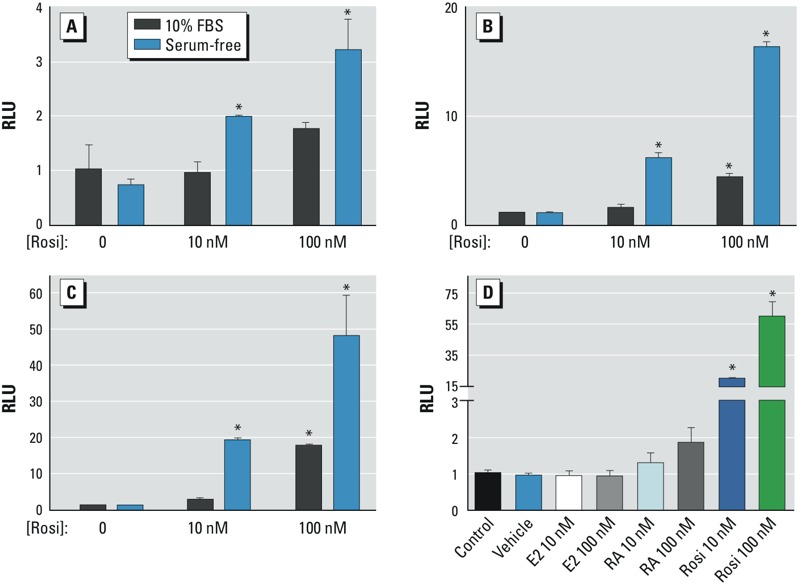
PPARγ transactivation activity in a GAL4-UAS system using serum-free conditions. HEK293T/17 cells were transfected and exposed to the PPARγ agonist Rosi under serum-containing (10% FBS) and serum-free (SF) conditions in triplicate, and luciferase activities were measured following exposure for (A) 4 hr, (B) 8 hr, and (C) 18 hr. Data in A–C are normalized to the 10% FBS control within each time point. Assay sensitivity is greatly enhanced under SF conditions. (D) HEK293T/17 cells were transfected and exposed to estrogen (E2), all-trans-retinoic acid (RA), or Rosi under SF conditions, and luciferase activities were measured, demonstrating ligand-specific responsiveness of the system. Data in D are normalized to the untreated control. RLU, relative light units. Data are expressed as mean ± SD; n = 3 per group (*p < 0.05 vs. control).